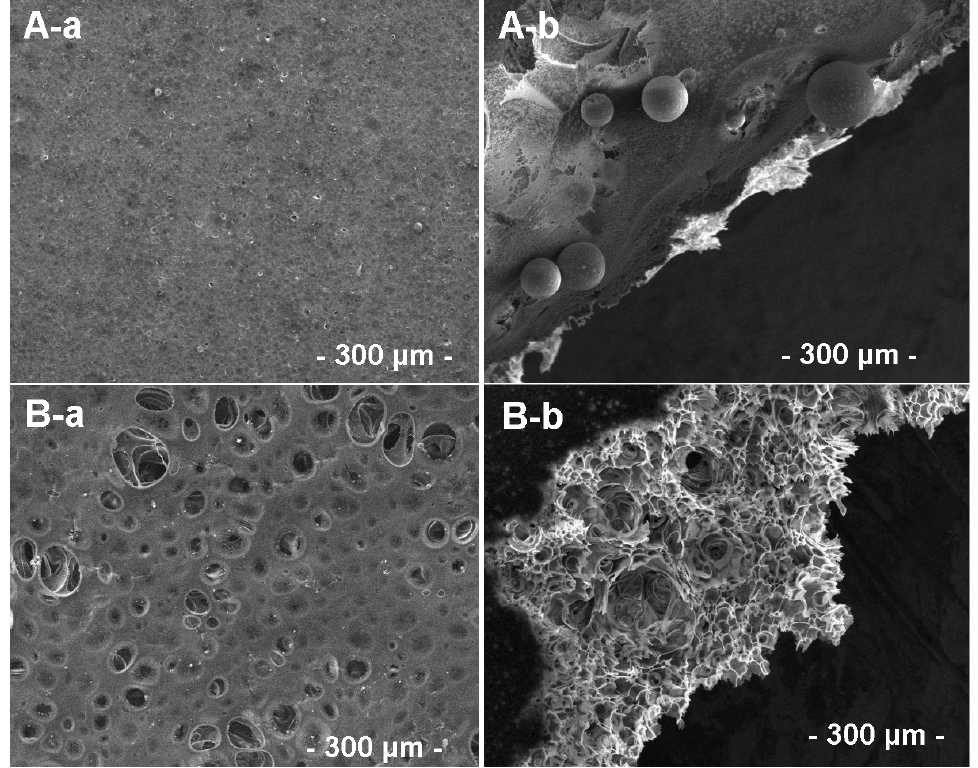
Figure 7. SEM images of prepared membranes: CA/PEG, top ( A-a ); CA/PEG, section ( A-b ); CA/PEG/CHI-Ag, top ( B-a ); CA/PEG/CHI-Ag, section ( B-b ).